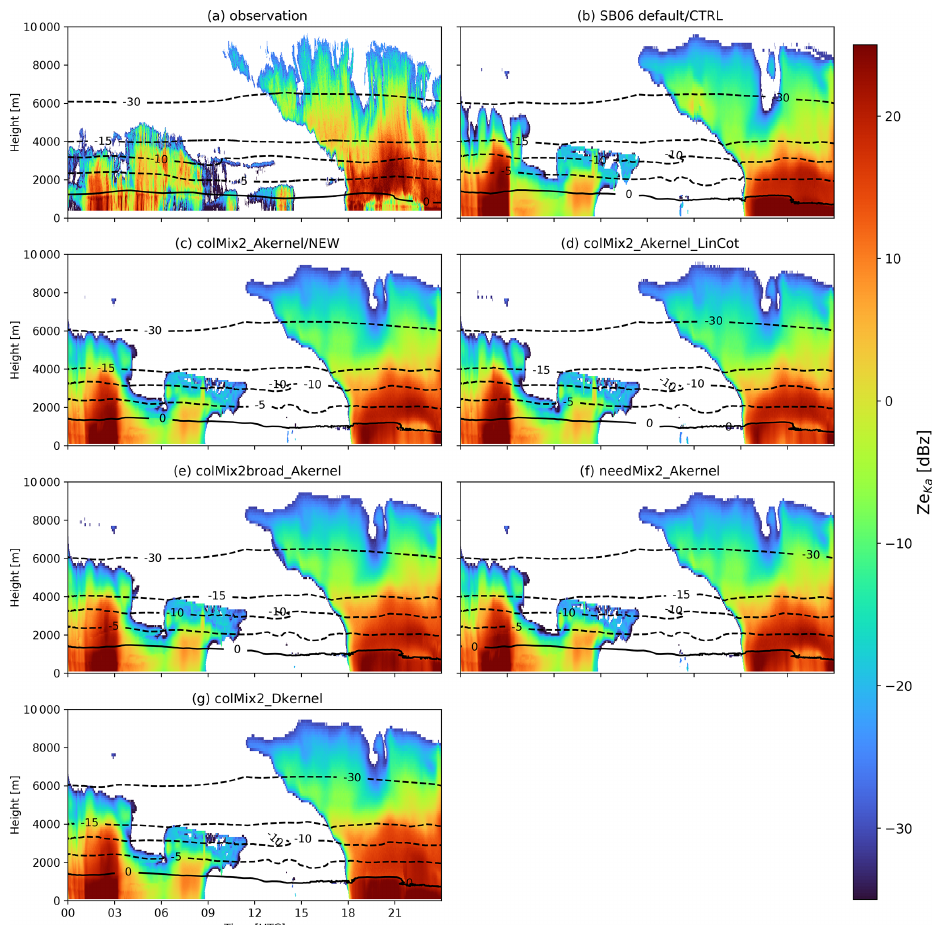
Figure 8. Time–height profile of Ze Ka from 3 January 2016 as observed (a) and simulated (b–g) with various model settings (Table 3). Selected temperature isolines from CloudNet (Illingworth et al., 2007) for the observations (a) and the corresponding ICON-LEM output (b– g) are also